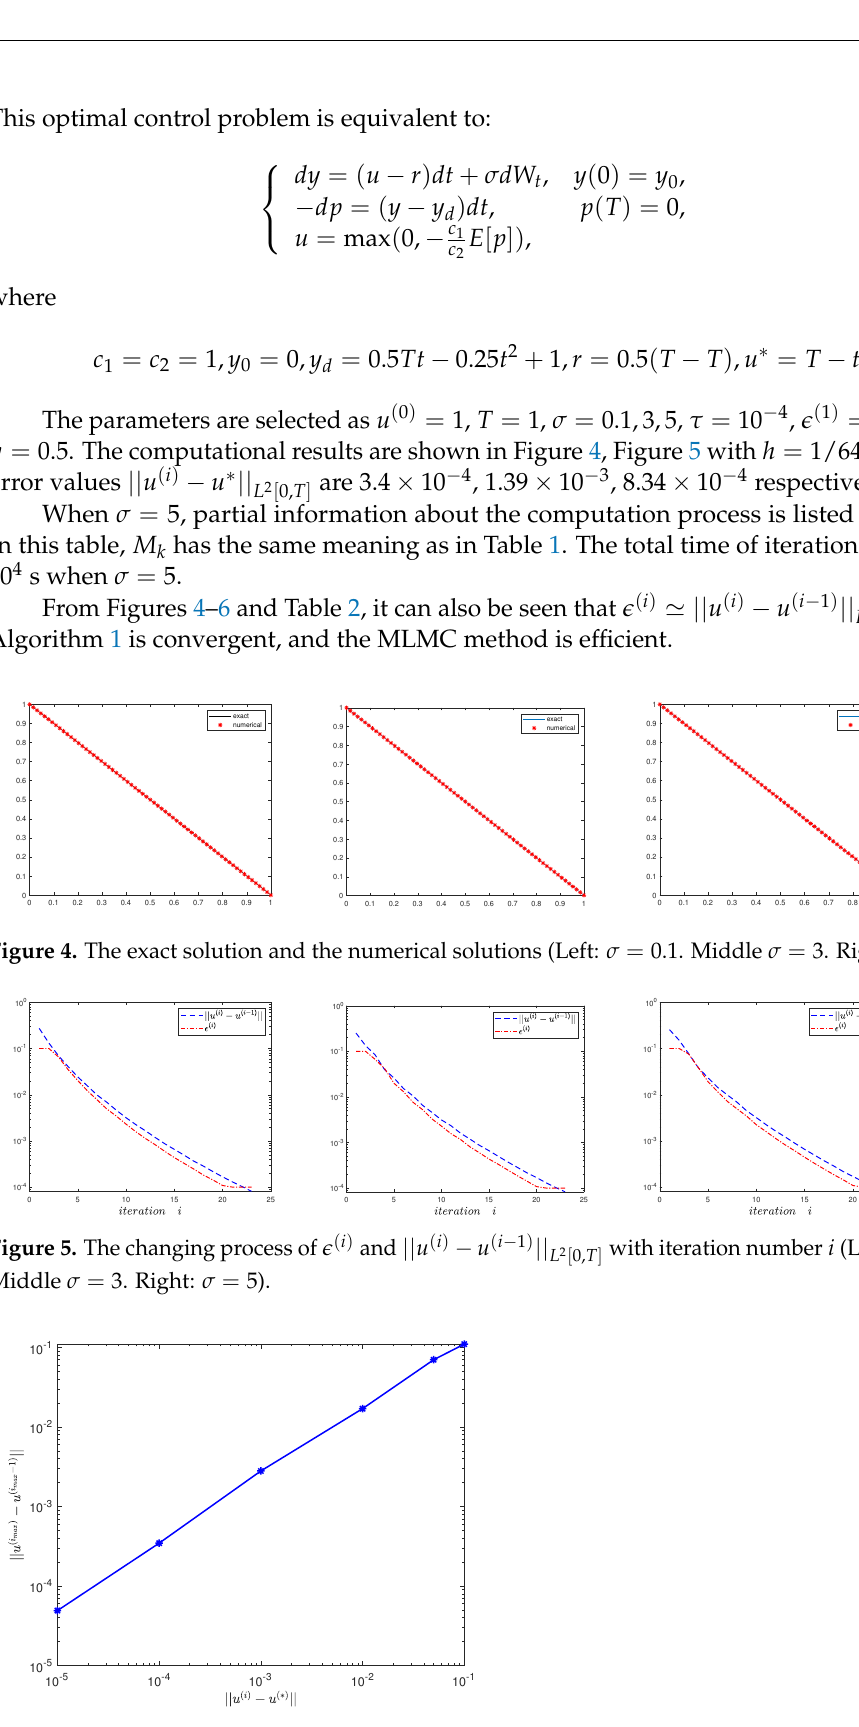
Figure 6. The changeing process of || u ( i max ) − u ( i max − 1 ) || L 2 [ 0, T ] with the iterative error τ ( σ =